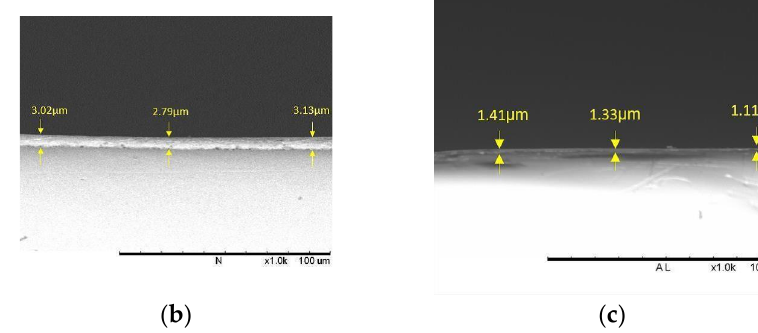
Figure 19. Coating layer using different dispersion methods: ( a ) Ultrasonic agitation ( b ) Magnetic stirring ( c ) Argon gas agitation (10 nm AgNP sample) .